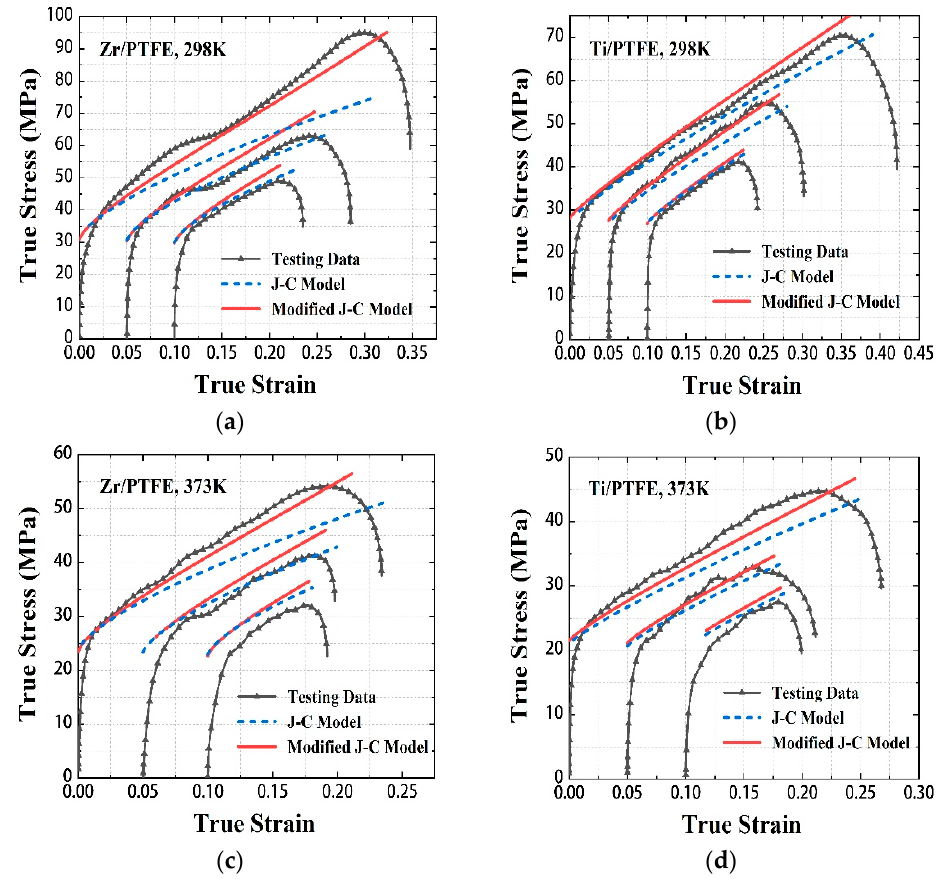
Figure 8. Comparisons of the true stress under dynamic loading for Zr/PTFE, Ti/PTFE between two model predictions and testing data. ( a ) Zr/PTFE, 298 K. ( b ) Ti/PTFE, 298 K. ( c ) Zr/PTFE, 373 K. ( d ) Ti/PTFE, 373 K.